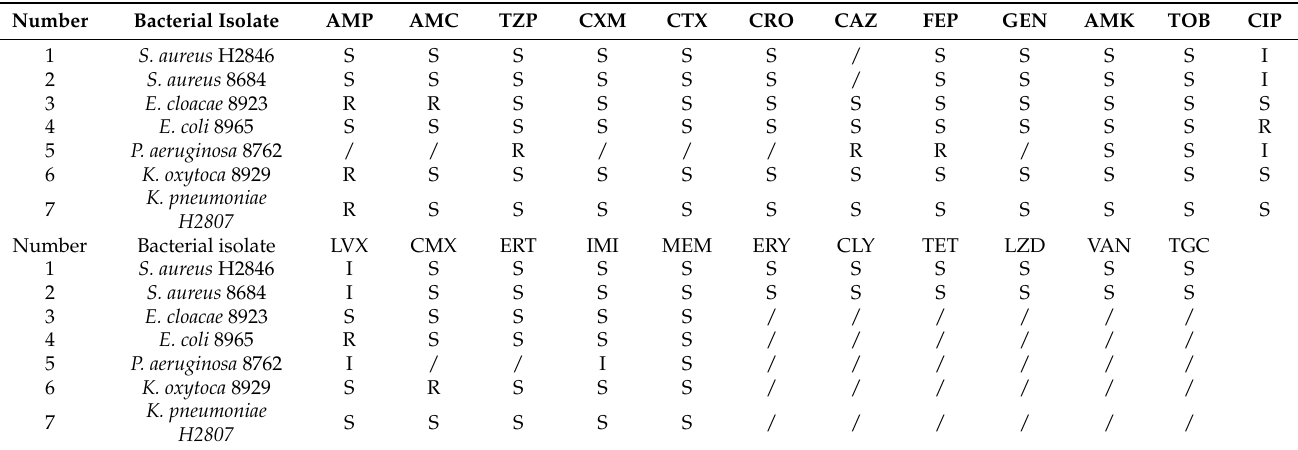
Table 7. Antibiotic susceptibility patterns for respiratory-associated bacteria (S—sensitive, I— intermediate,